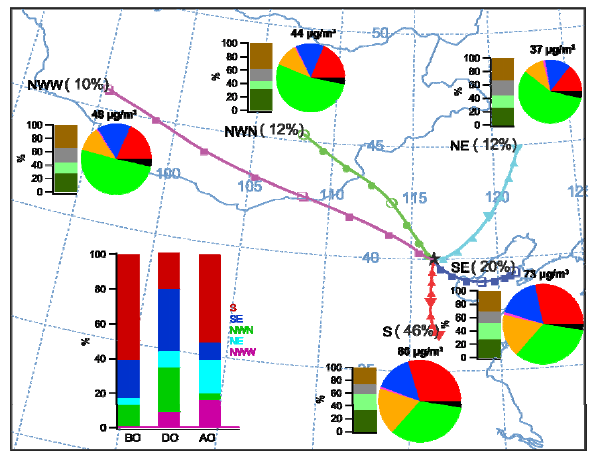
Fig. 5. The back trajectory clusters associated the corresponding average PM 1 compositions during the campaign. The inserted bar graph shows the directional variation of BTs before the Olympics (BO, July 23–August 7), during the Olympics (DO, August 8–24) and after the Olympics (AO, August 25–September 20).